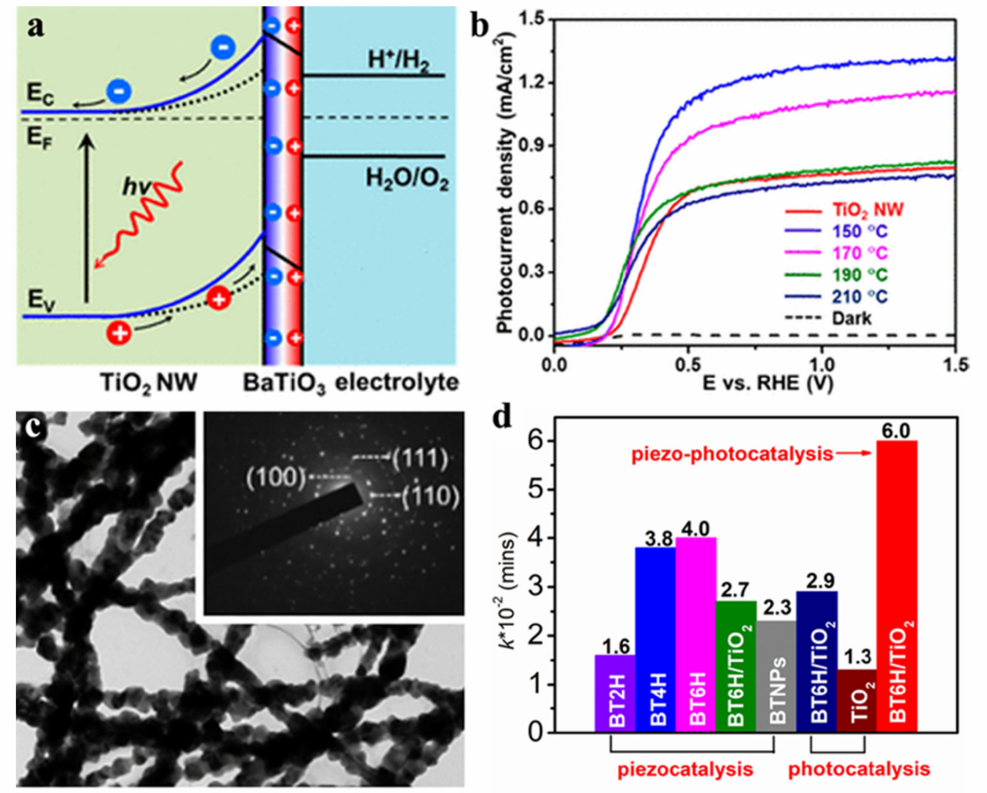
Figure 1. ( a ) The scheme of ferroelectric polarization-endowed band engineering of TiO 2 /BTO core/shell nanowires. ( b ) Photocurrent density-potential curves of TiO 2 NWs and TiO 2 /BTO NWs under AM1.5G illumination. Adapted with permission from ref. [37]. Copyright: 2015, American Chemical Society. ( c ) TEM and SAED of necklace-like BaTiO 3 nanofibers; ( d ) the comparison of the corresponding K values for degradation of MO by BT6H@TiO 2 core-shell nanofibers under various catalytic conditions. Adapted with permission from ref. [38]. Copyright: 2022,